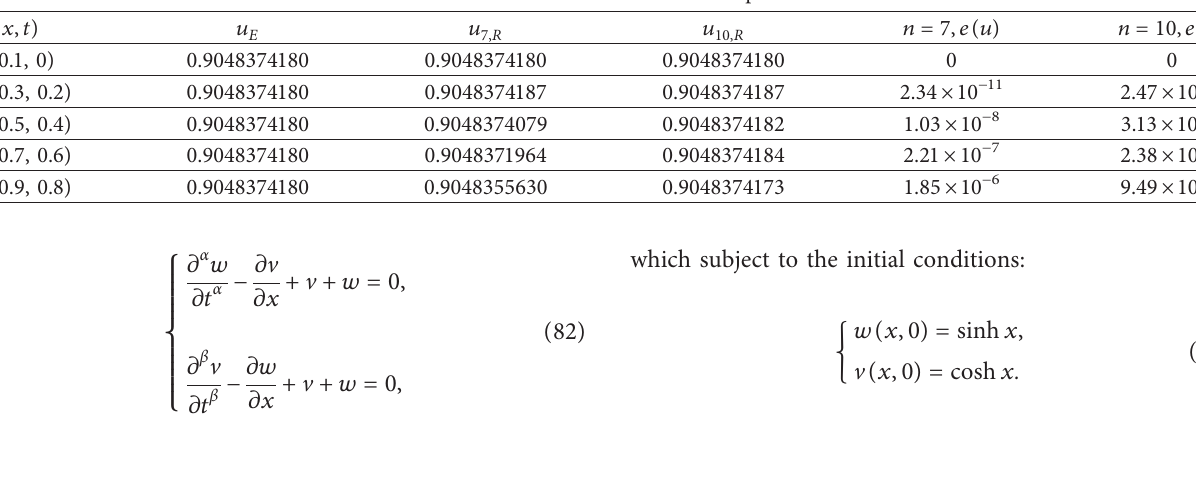
Table 6: Numerical result of Example